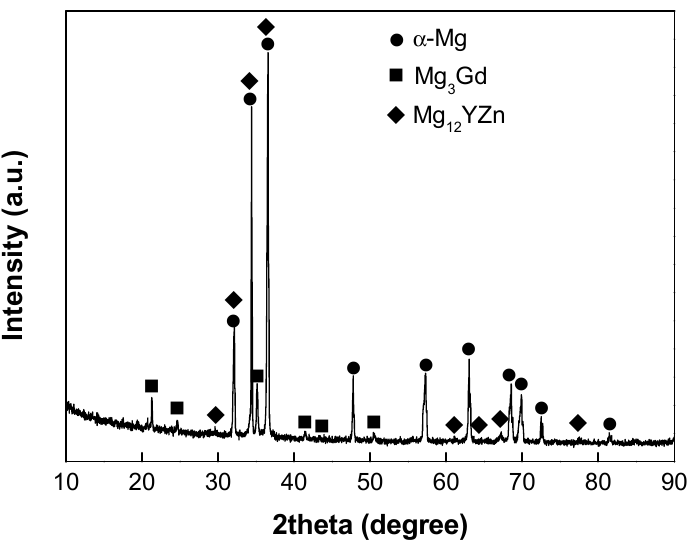
Figure 2. XRD pattern of as-cast alloy (XRD: X-Ray diffractometer).